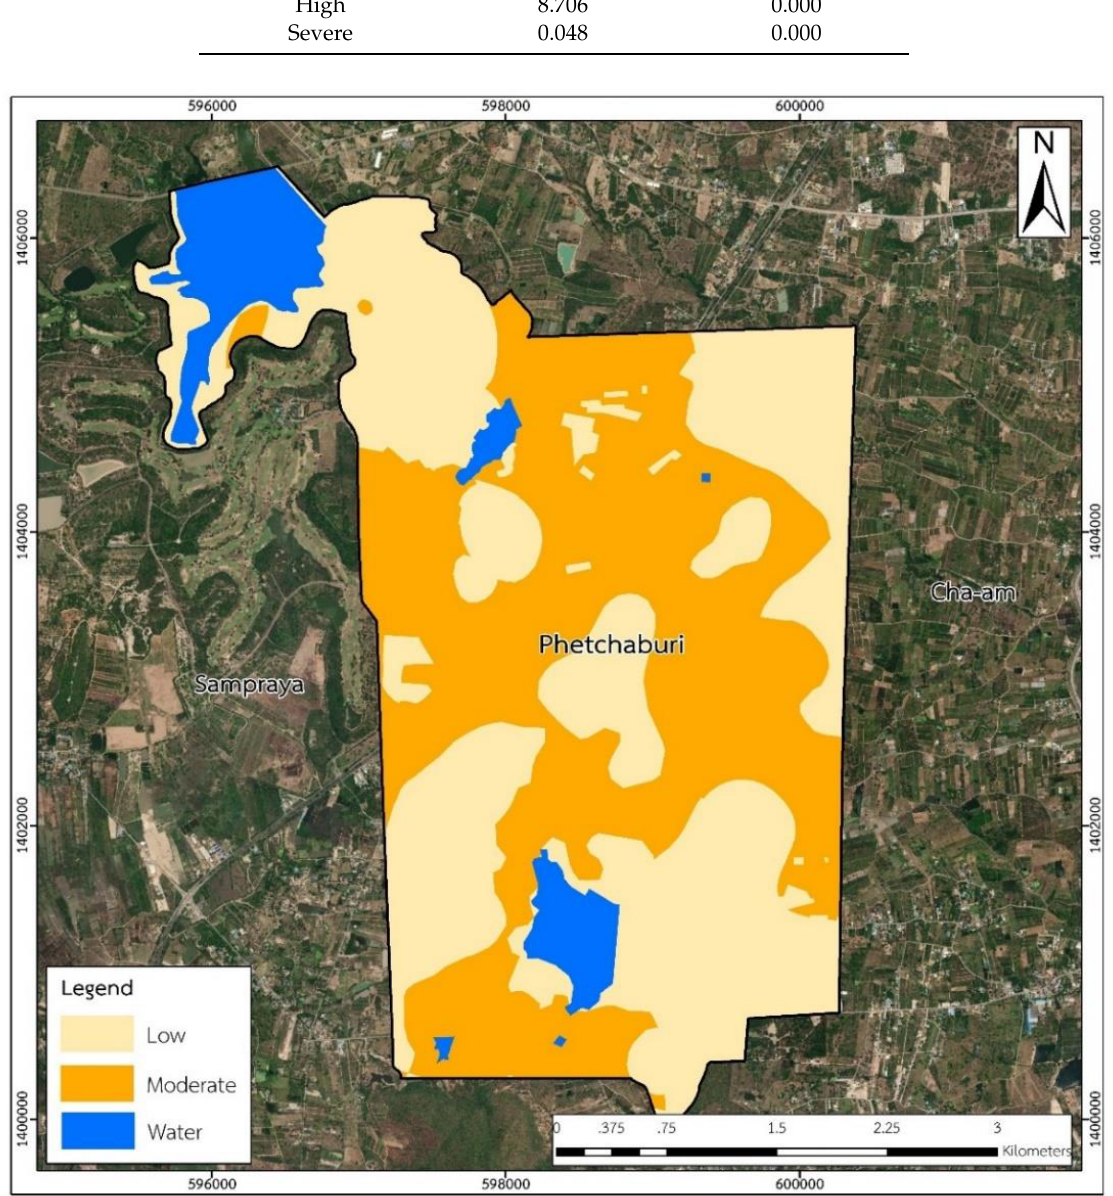
Figure 5. Risk in Huay Sai When All Three Restoration Mitigations are Applied.